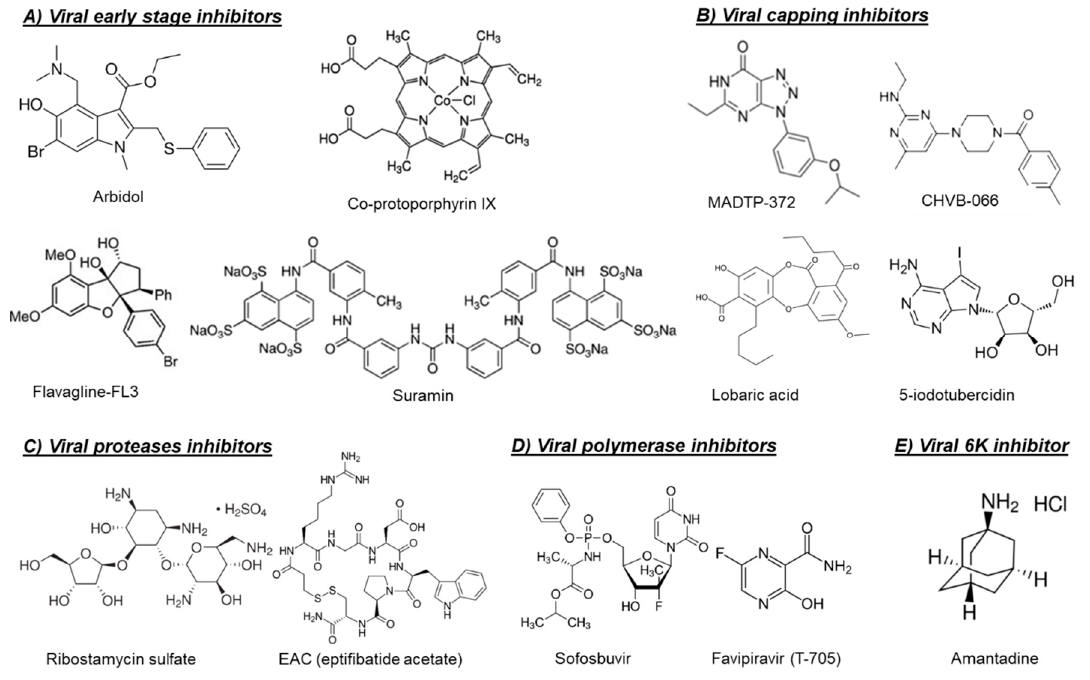
Figure 2. Chemical structures of selected virus-targeting alphavirus inhibitors.